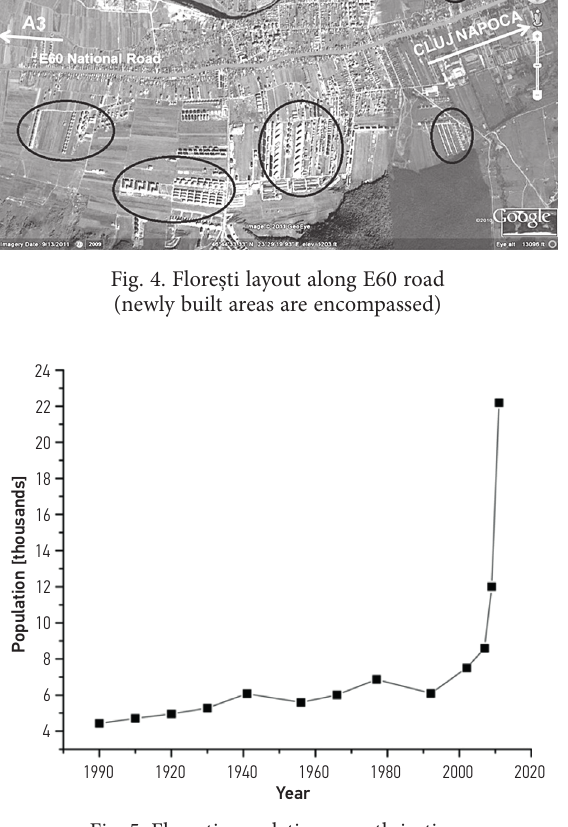
Fig. 5. Florești population growth in